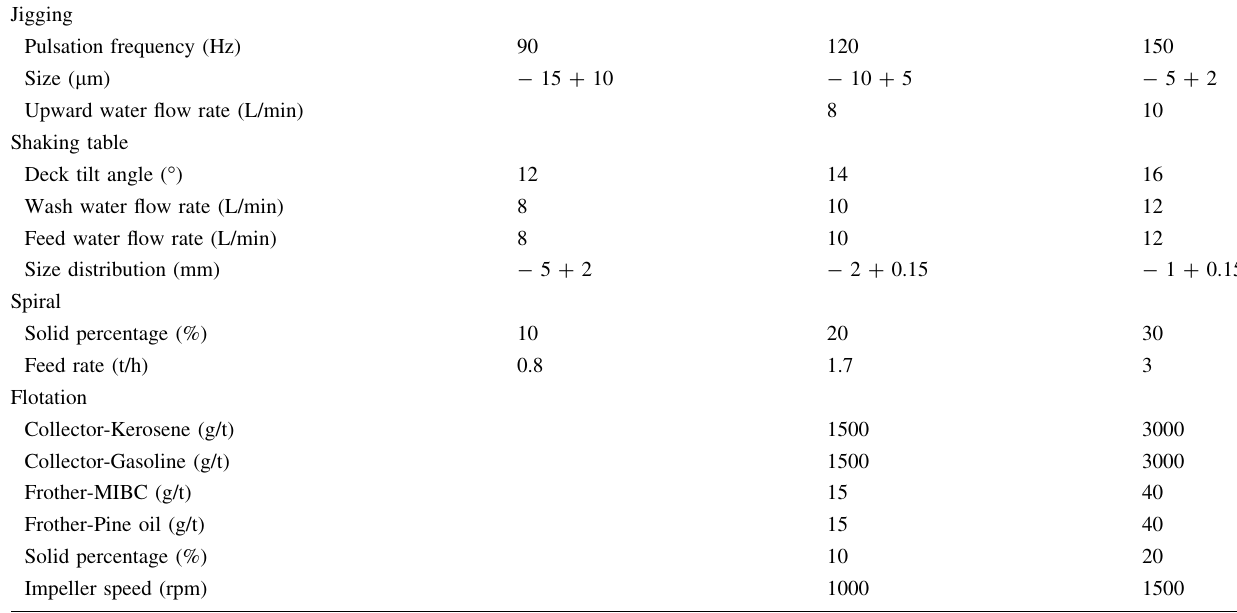
Table 2 Levels of important variables for various separation methods were used for the experimental design